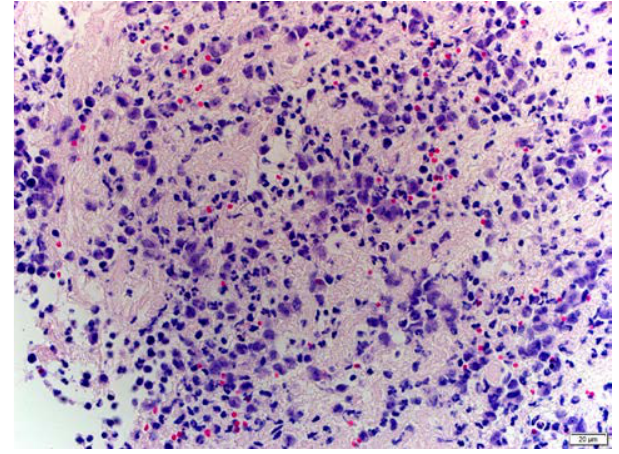
Figure 2A: H&E stained section through the pelleted effusion at 40x magnification showing neutrophils, macrophages, a few lymphocytes, pale eosinophilic background fibrin and occasional enmeshed